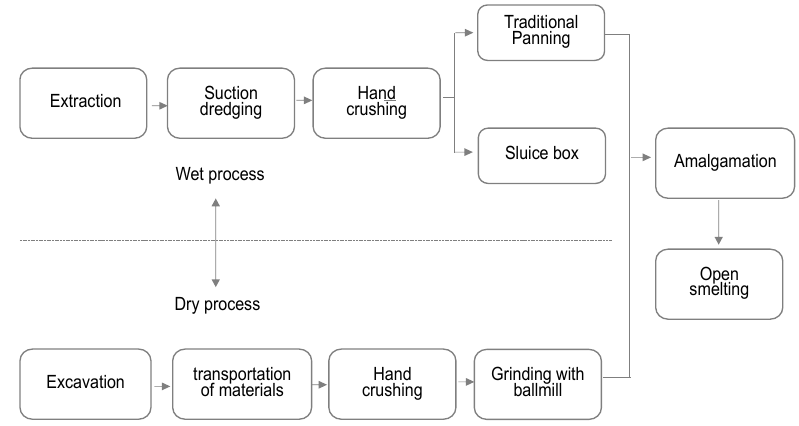
Figure 2. Regularly flow sheet of artisanal and small-scale gold mining and gold processing in Bombana.